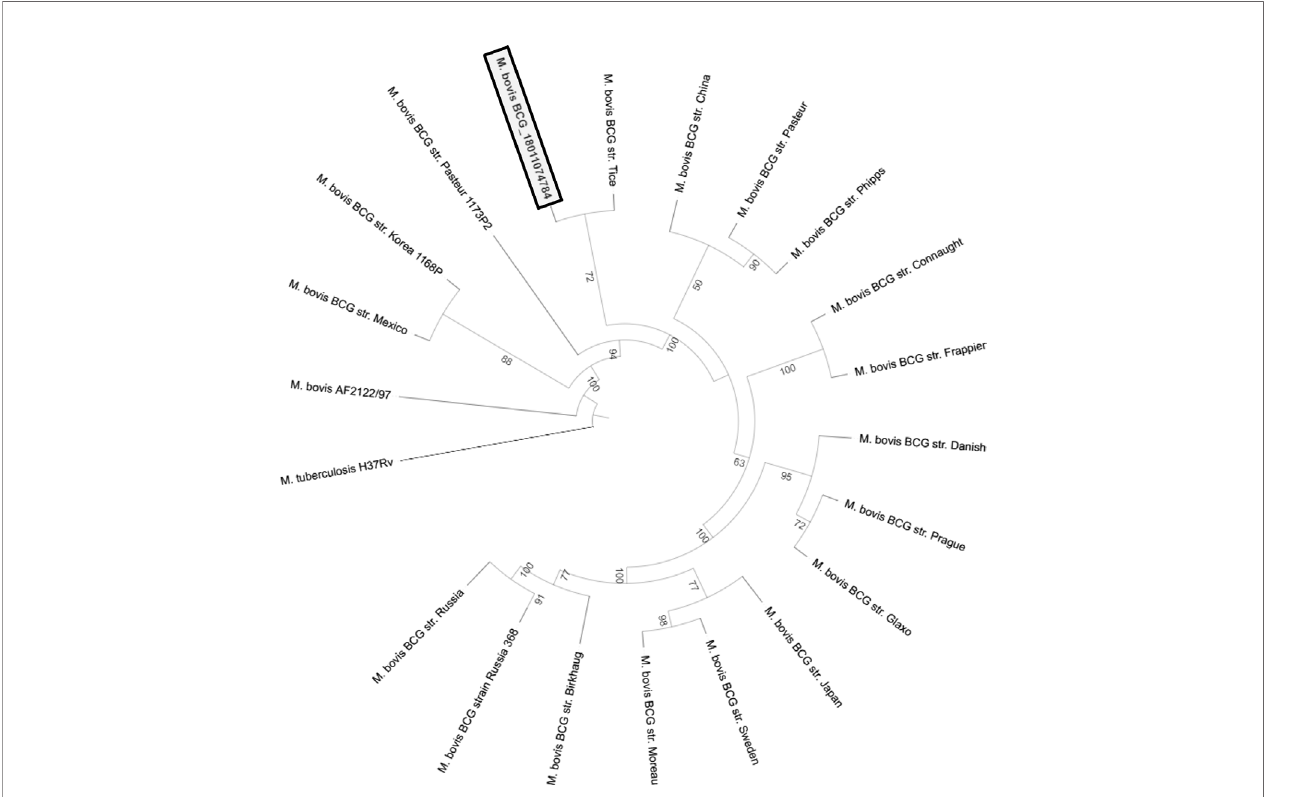
FIGURE 4 | Maximum likelihood phylogenetic tree representing the relationship between the clinical M. bovis BCG strain ( M. bovis BCG_1811074784) and reference M. bovis BCG strains. Bootstrap values of each branch are